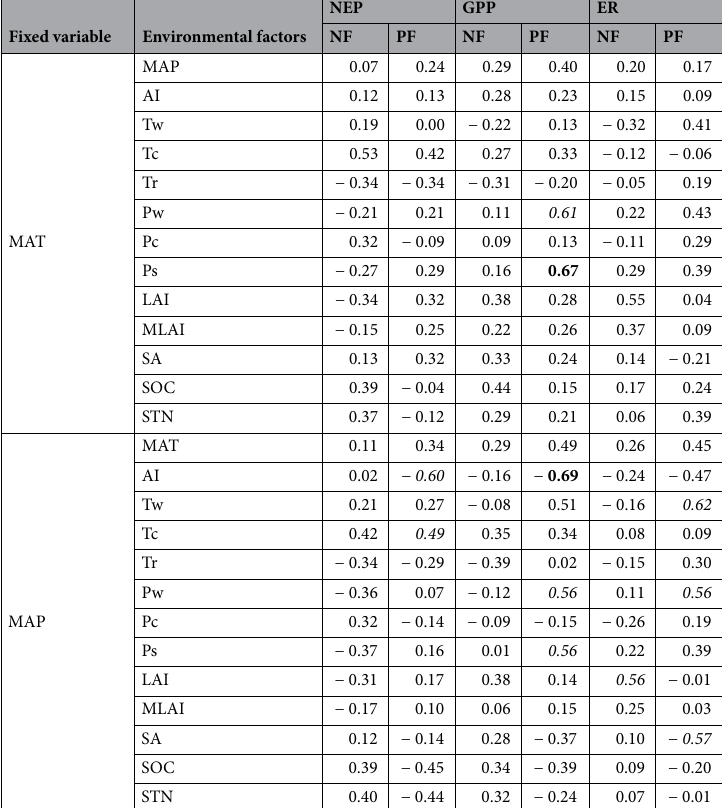
Table 2. Partial correlation coefficients between carbon fluxes and environmental factors in naturally regenerating forests (NF) and planted forests (PF) with fixing mean annual air temperature (MAT) or mean annual precipitation (MAP). Carbon fluxes include net ecosystem productivity (NEP), gross primary productivity (GPP), and ecosystem respiration (ER). The abbreviations of the environmental factors are the same as those in the legend of Fig. 1. Italics and bold indicate significant correlation coefficients at α = 0.05 and α = 0.01,